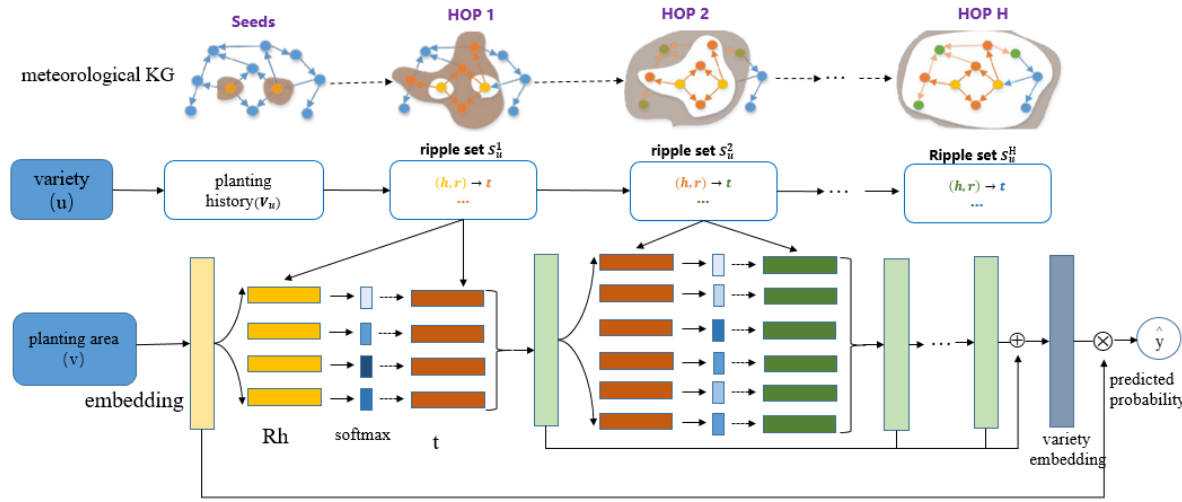
Figure 5. Recommendation model of suitable planting area based on RippleNet.